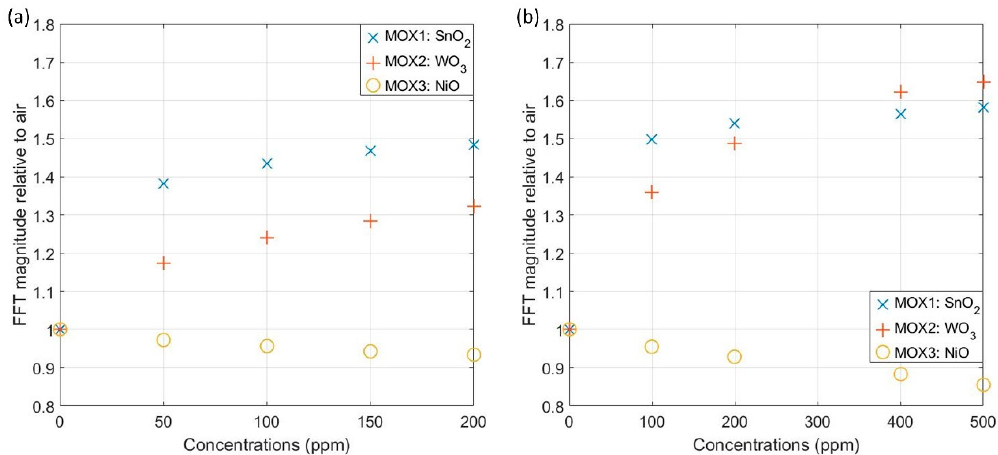
Figure 8. FFT magnitude relative to air results of three sensors: SnO 2 , WO 3 and NiO in acetone ( a ) and ethanol ( b ).